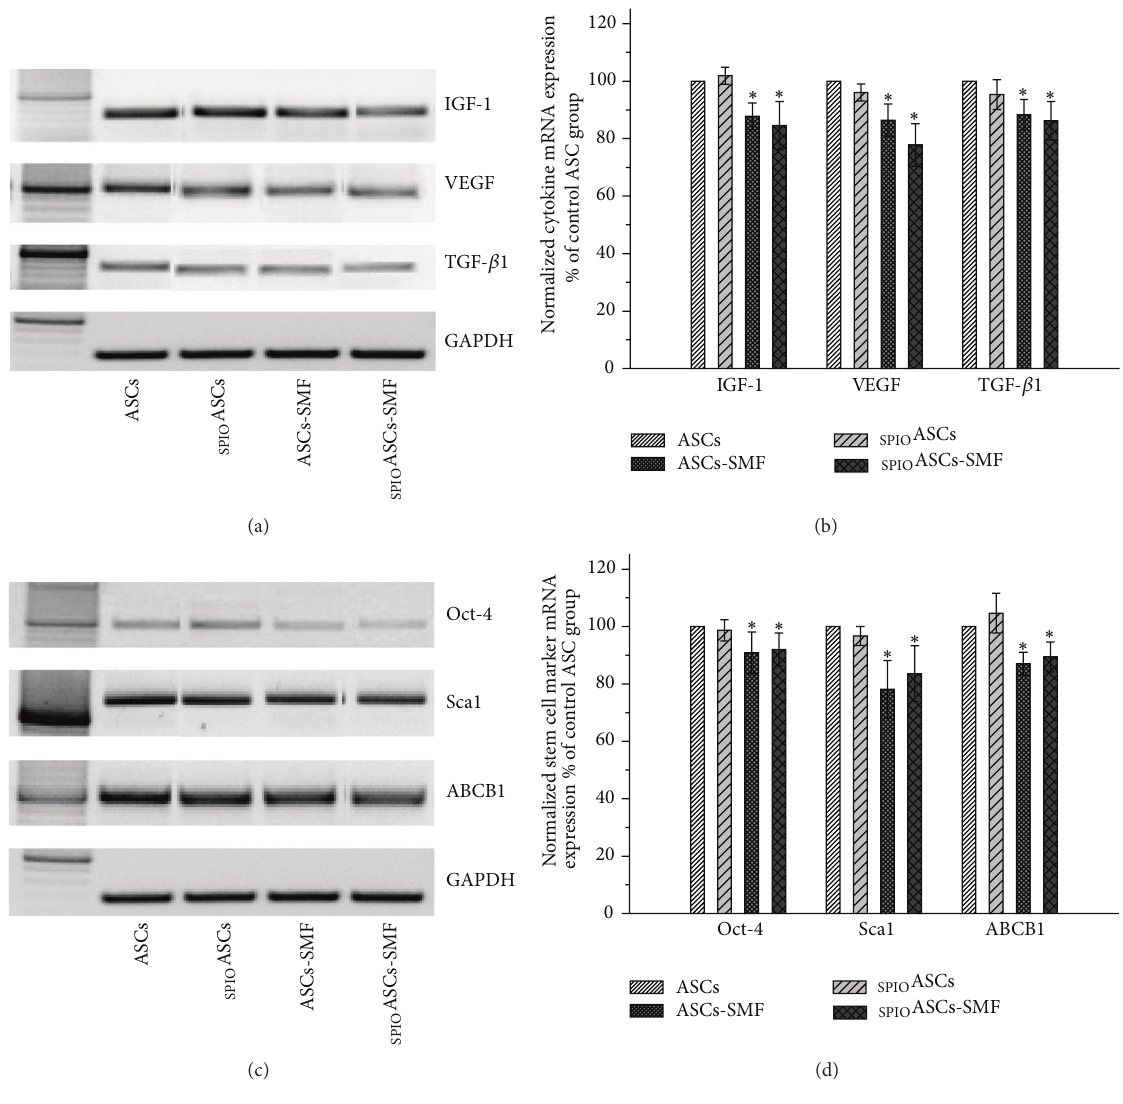
Figure 5: Effect of seven-day exposure to 0.5 T SMF on cytokine secretion and stem cell genetic marker expression in ASCs and SPIO ASCs. (a) Representative results of RT-PCR for IGF-1, VEGF, and TGF- 𝛽 1. (b) Quantification after normalization to levels from control ASCs. The expression of mRNA for IGF-1, VEGF, and TGF- 𝛽 1 was significantly lower in the ASCs-SMF and SPIO ASCs-SMF than in ASCs and SPIO ASCs. (c) Representative results of RT-PCR for Sca1, ABCB1, and Oct-4. (d) Quantification after normalization to levels from control ASCs. The expression of mRNA for Sca1, ABCB1, and Oct-4 was significantly lower in the ASCs-SMF and SPIO ASCs-SMF than in ASCs and SPIO ASCs. ∗ 𝑃 < 0.05 versus ASCs or SPIO ASCs.